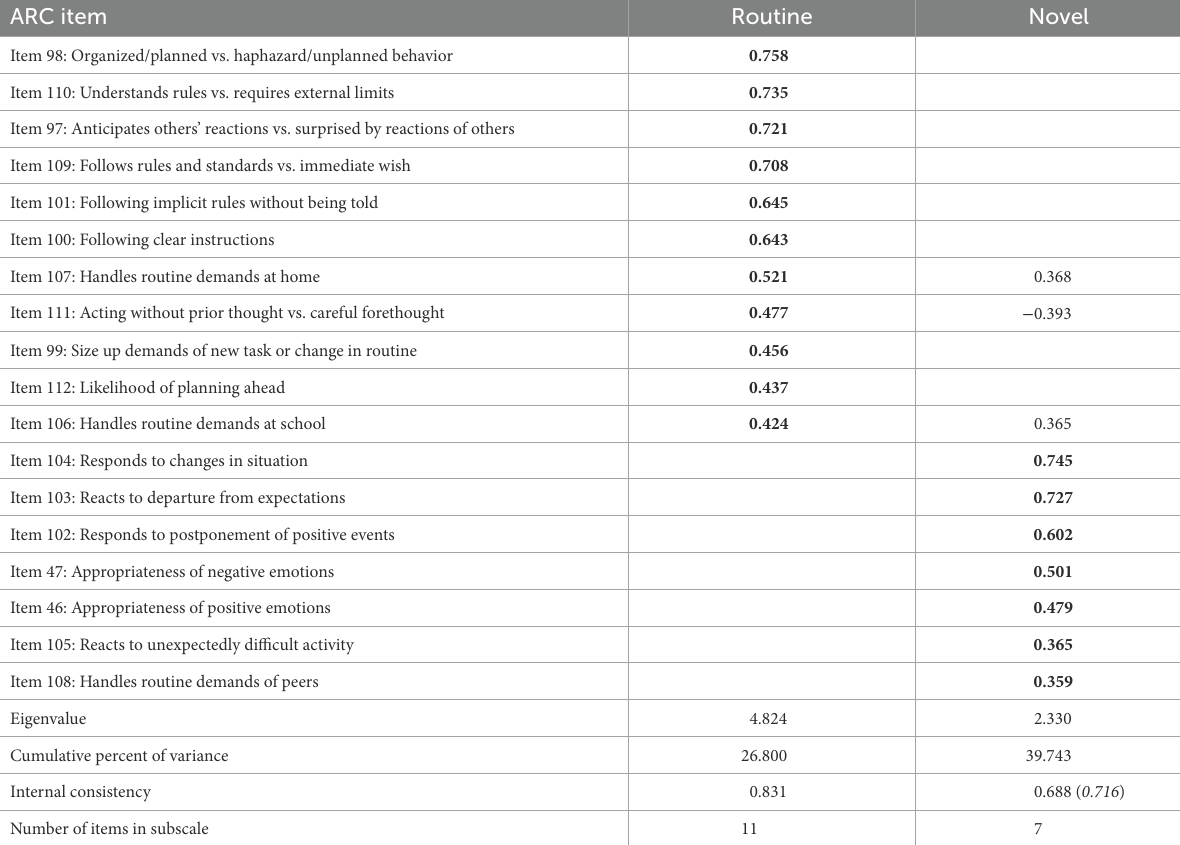
TABLE 1 Factor loadings for exploratory factor analysis with varimax rotation for ARC scale. ARC